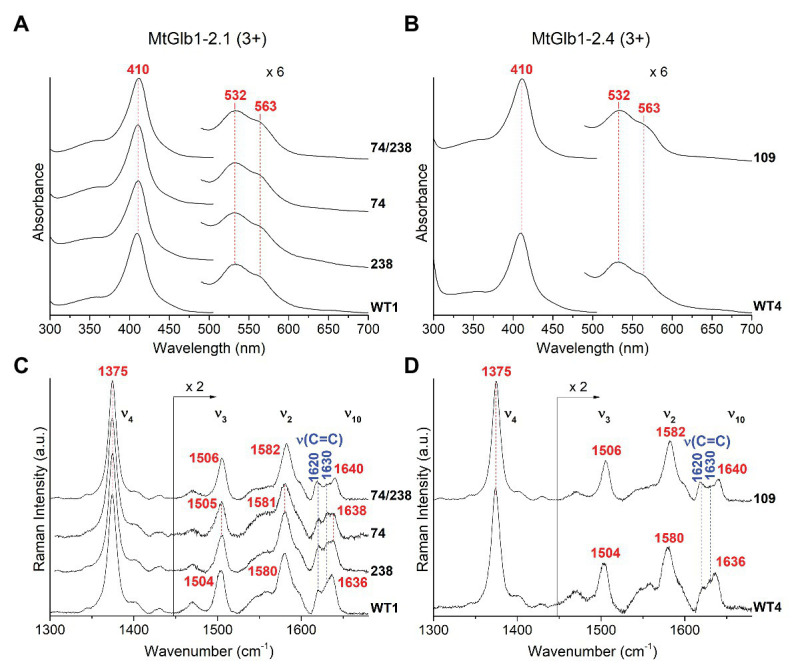
Spectroscopic characterization of the ferric form (3+) of MtGlb1-2.1 and MtGlb1-2.4. (A,B) UV-Vis and (C,D) RR spectra in the high frequency region of ferric WT1, WT4, and their mutants. The wavelength of the UV-Vis bands and the wavenumbers of the RR core size marker bands of the 6cLS species and the RR vinyl v(C=C) stretching modes are reported in red and blue, respectively. The spectra have been shifted along the y-axis. The 490–700 nm region of the UV-Vis spectra and the 1,450–1,700 cm−1 region of the RR spectra are expanded 6‐ and 2-fold, respectively, to facilitate visualization. The intensity of the RR spectra is normalized to the v4 band. RR experimental conditions: laser excitation 406.7 nm; laser power at the sample, 5 mW; and number of spectra used to calculate the average spectrum x integration time in minutes: (C) WT1 (4 × 40), 74 (4 × 40), 74/238 (4 × 40), and 238 (7 × 70). (D) WT4 (6 × 60) and 109 (4 × 40).